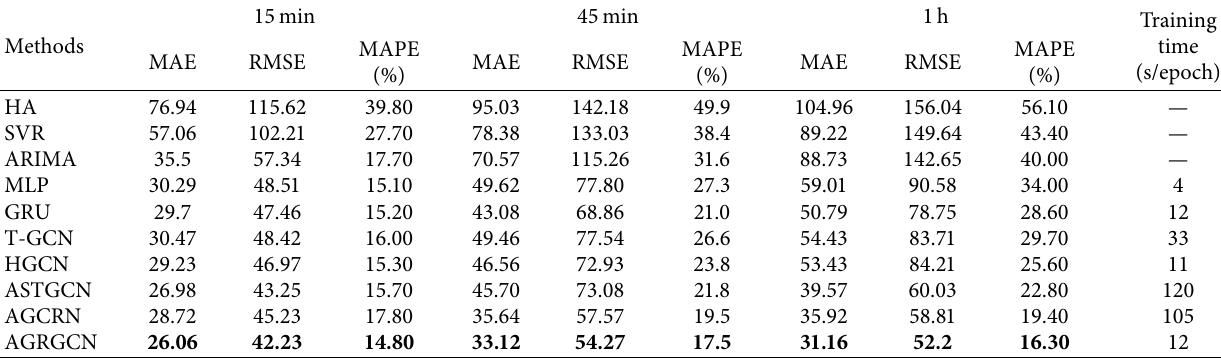
Table 3: Te prediction performance of diferent model on the HW-ENG dataset.